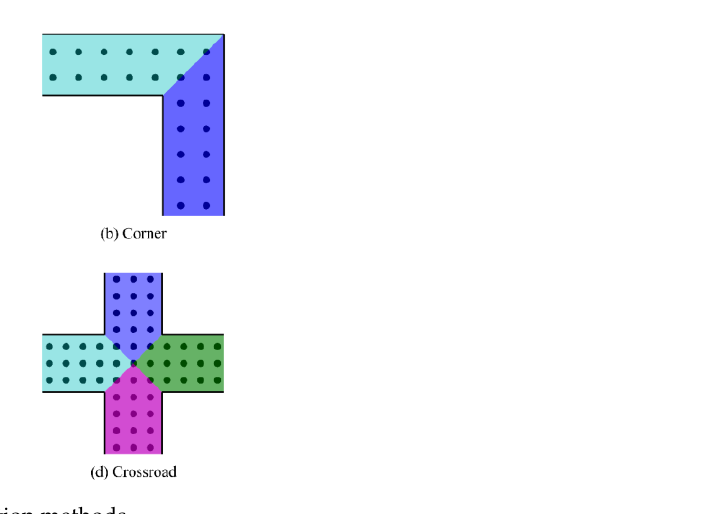
Figure 2. Some partition methods.